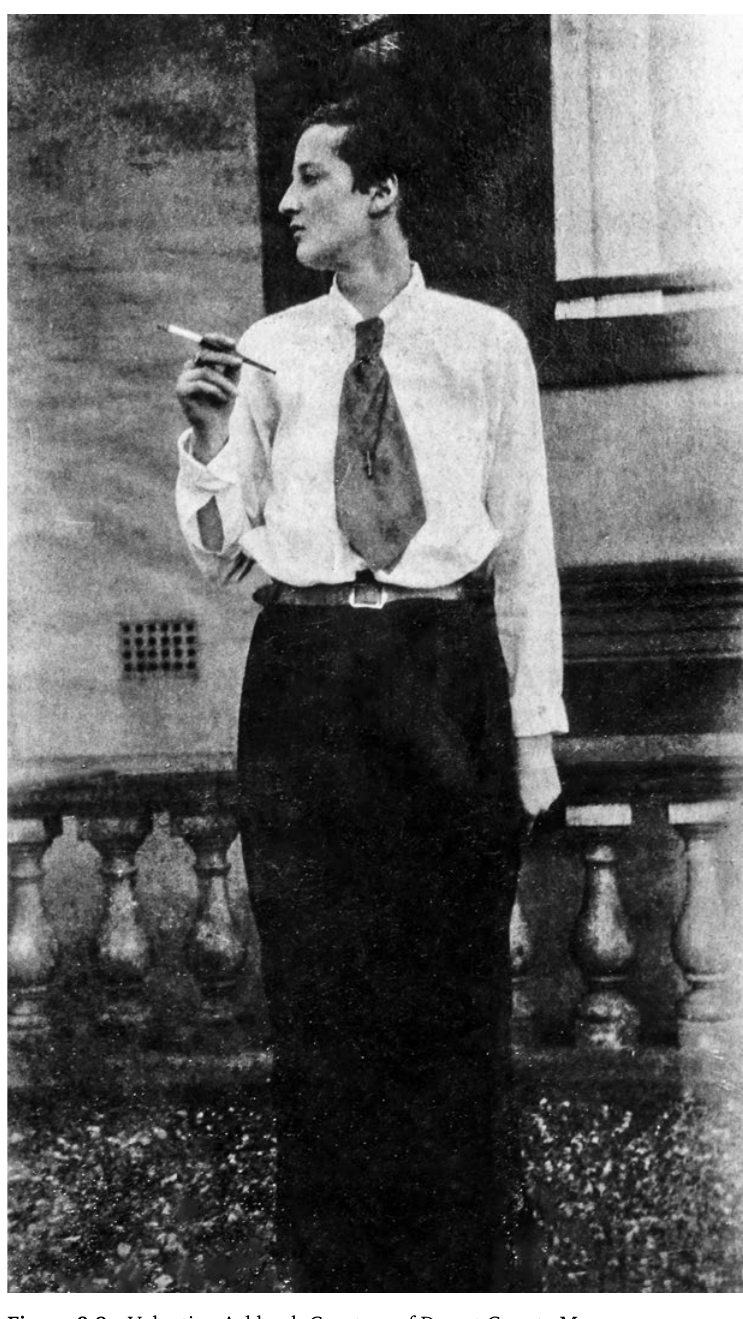
Figure 8.9 Valentine Ackland. Courtesy of Dorset County